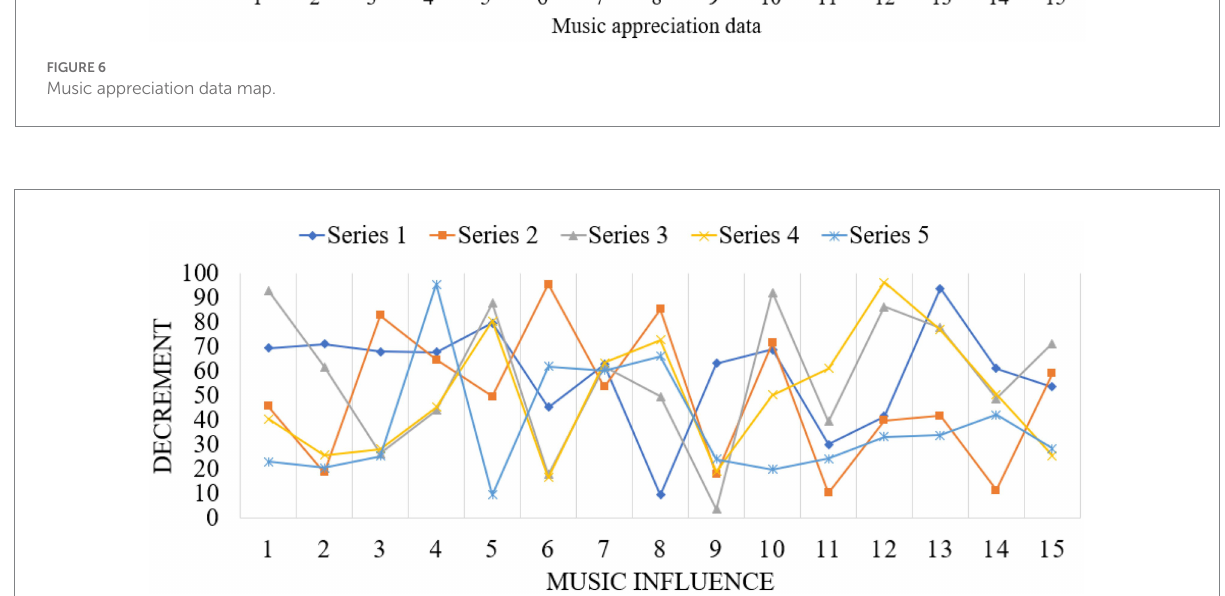
FIGURE 7 Data map of music education impact.